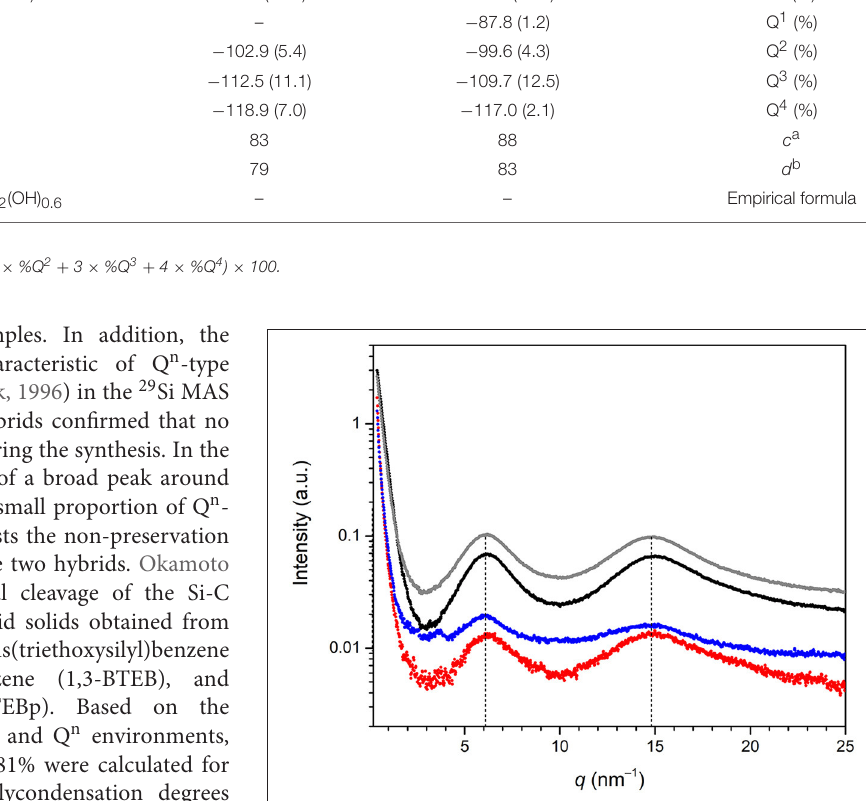
associated with the scattered signal observed at about 6.1 nm −